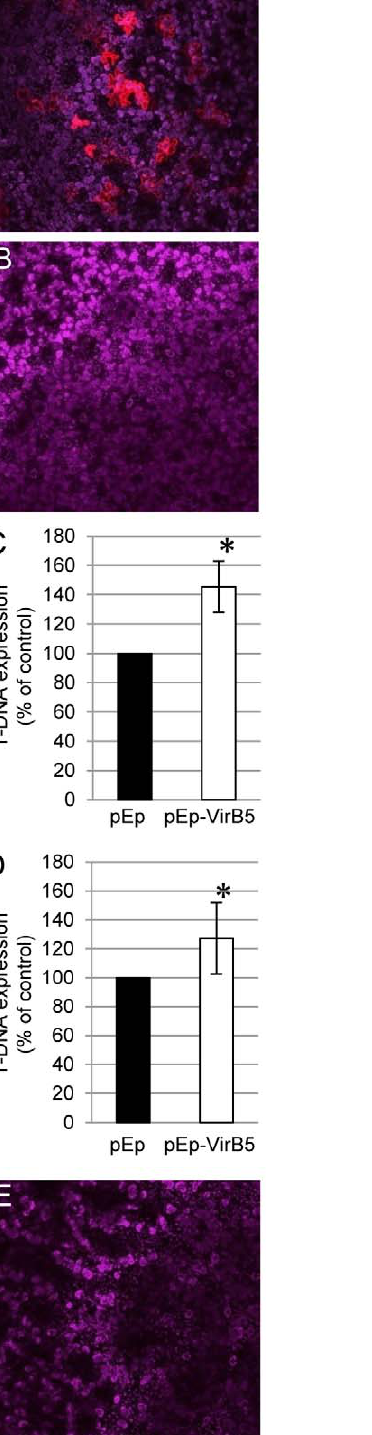
Figure 3. VirB5 overexpressed in Agrobacterium , but not exogenous VirB5, complements a mutation in the virB5 gene. (A) Agroinfiltration of tobacco leaves with CB1005 + pEp-VirB5. (B) Agroinfiltration of tobacco leaves with CB1005 + pEp. (C) Inoculation of tobacco leaf discs with EHA105 + pEp-VirB5 or EHA105 + pEp. (D) Inoculation of sugar beet hypocotyl segments with EHA105 +